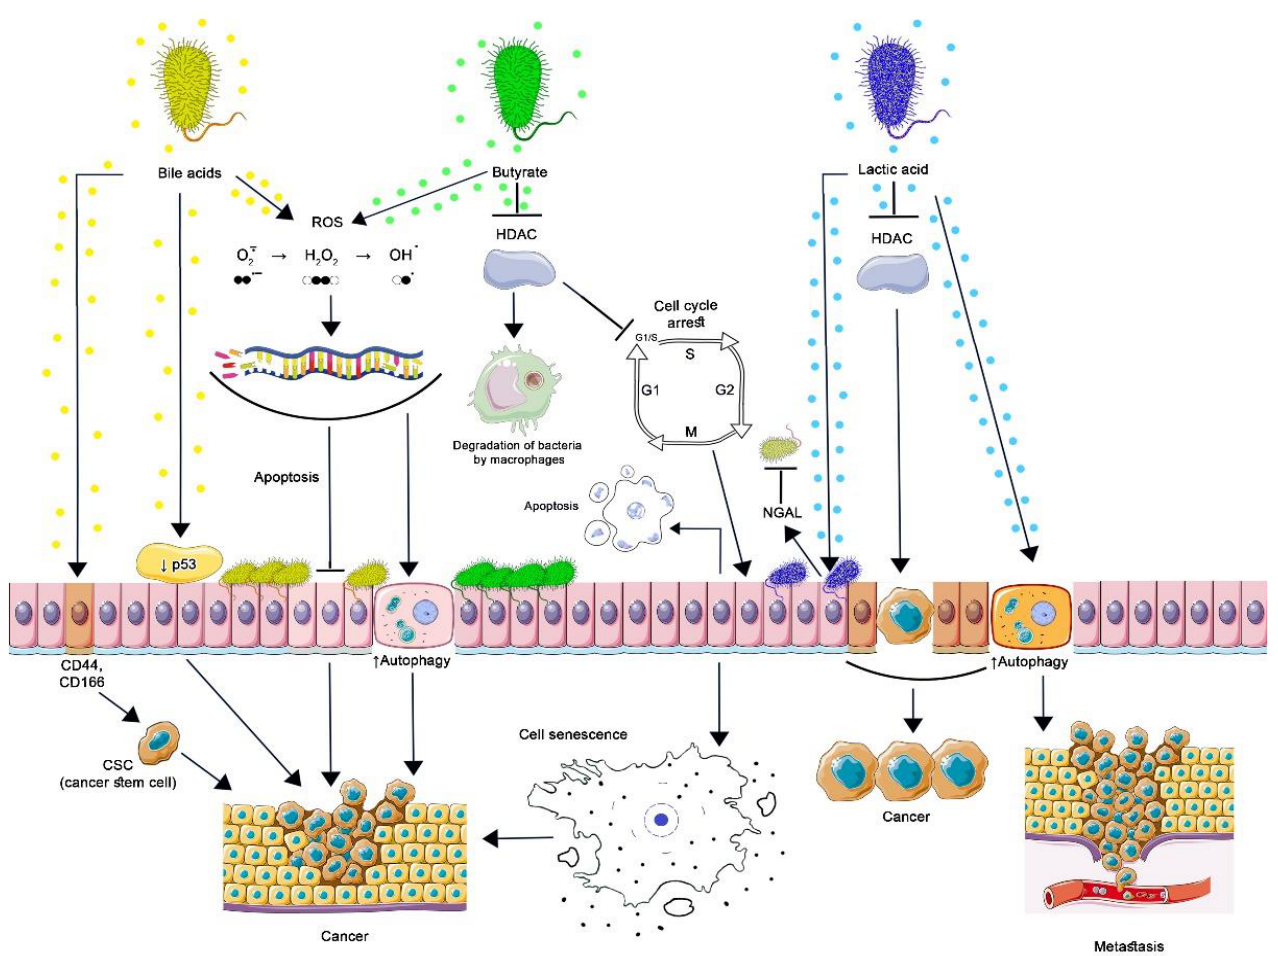
Figure 2. Contribution of commensal bacteria microbial metabolites to carcinogenesis. By stimulating the proteasomal degradation of p53 and inducing cancer stem cells (CSC), secondary BAs lead to malignant transformation of cells. Oxidative damage to DNA by secondary BA and butyrate is associated with the formation of ROS, which cannot be restored in genetically modified cells, which leads to the formation of resistance to apoptosis, increased autophagy, and cancer development. Butyrate inhibits HDAC in normal and cancer cells. The action of butyrate upon HDAC3 of intestinal macrophages reduces the activity of the mTOR protein, as a result of which autophagy in macrophages is enhanced. This is how butyrate-producing bacteria maintain the optimal level of their population. By inhibiting HDAC, butyrate induces the expression of p21, which arrests the cell cycle at the G1-S stage: cells can undergo apoptosis or acquire a senescence-associated secretory phenotype leading to the development or progression of cancer. By inhibiting the production of cyclic adenosine monophosphate (cAMP), lactic acid activates autophagy in vaginal epithelial cells, protecting them from intracellular microorganisms. Protective autophagy in tumor cells prevents apoptosis, promoting tumor metastasis. By blocking HDAC, lactic acid increases the production of NGAL by epithelial cells, which inhibits the growth of other microorganisms, inducing selective transcription of genes in malignantly transformed cells, which contributes to their survival and stimulates oncogenesis. (Figure 2 was created using images from Servier Medical Art https://smart.servier.com/ 26 June 2022). Energy metabolism and microbial ecology are common to groups of butyrate-producing bacteria; therefore, to maintain their populations, they compete with carbohydrate-consuming Bacteroides spp. and have an advantage at a lower pH (5.5) of the proximal colon. This moderately acidic pH level occurs when there is a high level of bacterial fermentation of carbohydrates in the colon, which are not digested in the upper intestine [81]. Butyrate